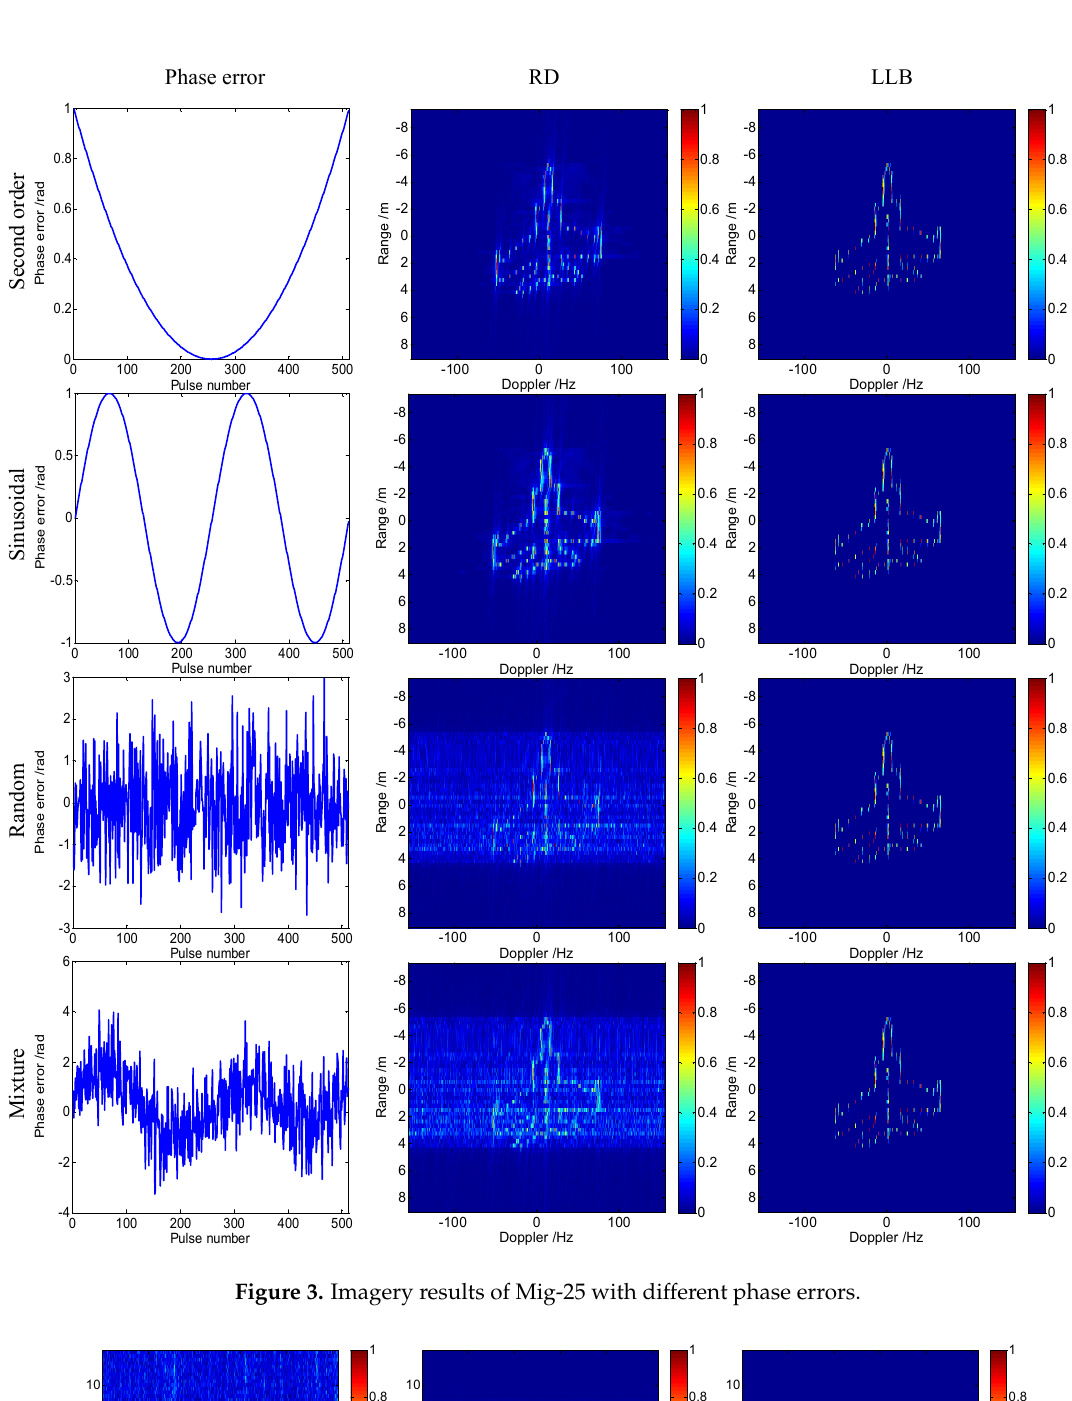
Figure 3. Imagery results of Mig-25 with different phase errors.